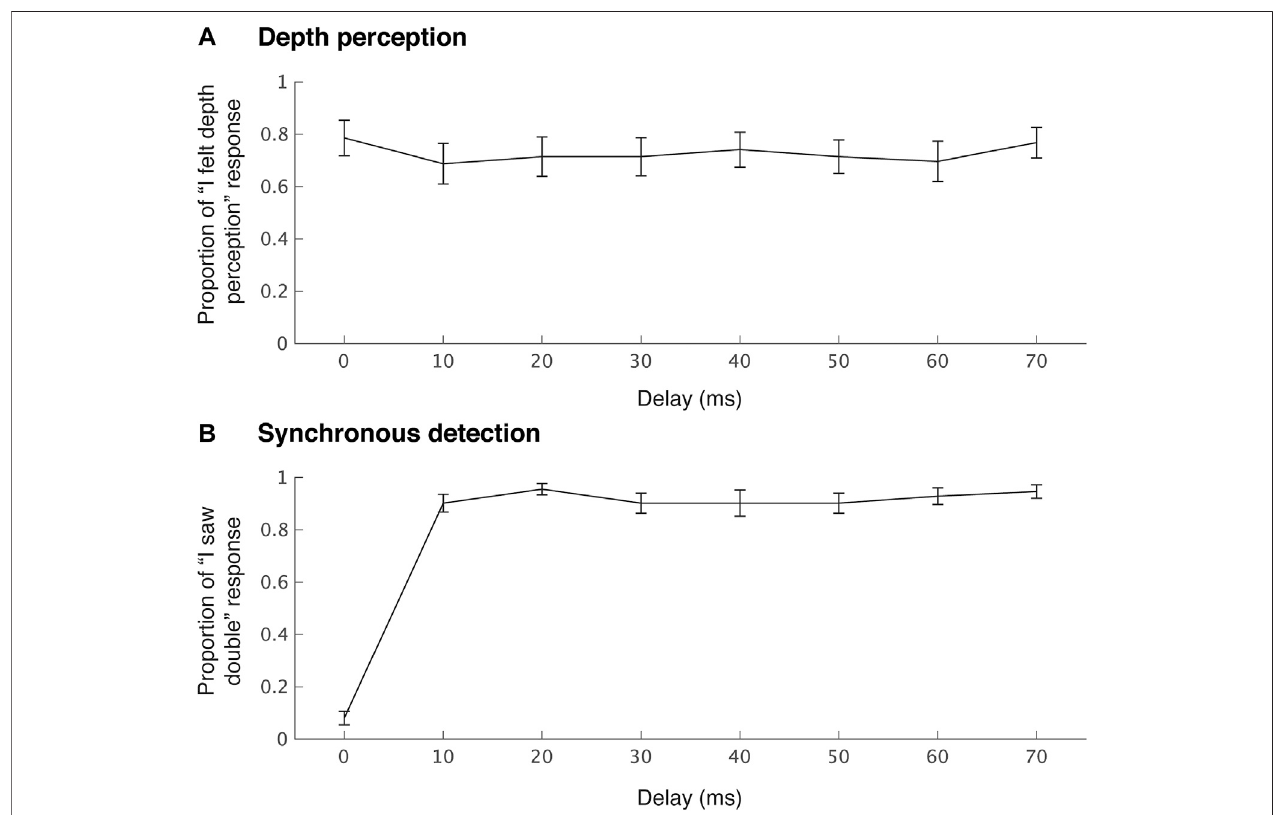
FIGURE 13 | Mean ratio of depth perception (A) and synchronous detection (B) in experiment two.